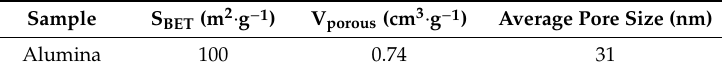
Table 2. Specific surface area and porous volume of alumina.